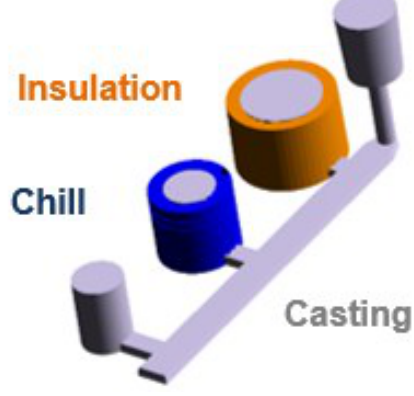
Figure 2. Cylindrical castings with the insulation and chill.